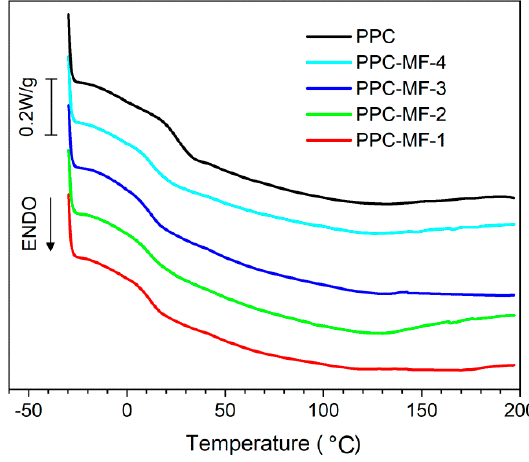
Figure 2. The DSC curves for PPC and Figure 2 . The DSC curves for PPC and PPC-MFs. Figure 2 . The DSC curves for PPC and PPC-MFs.